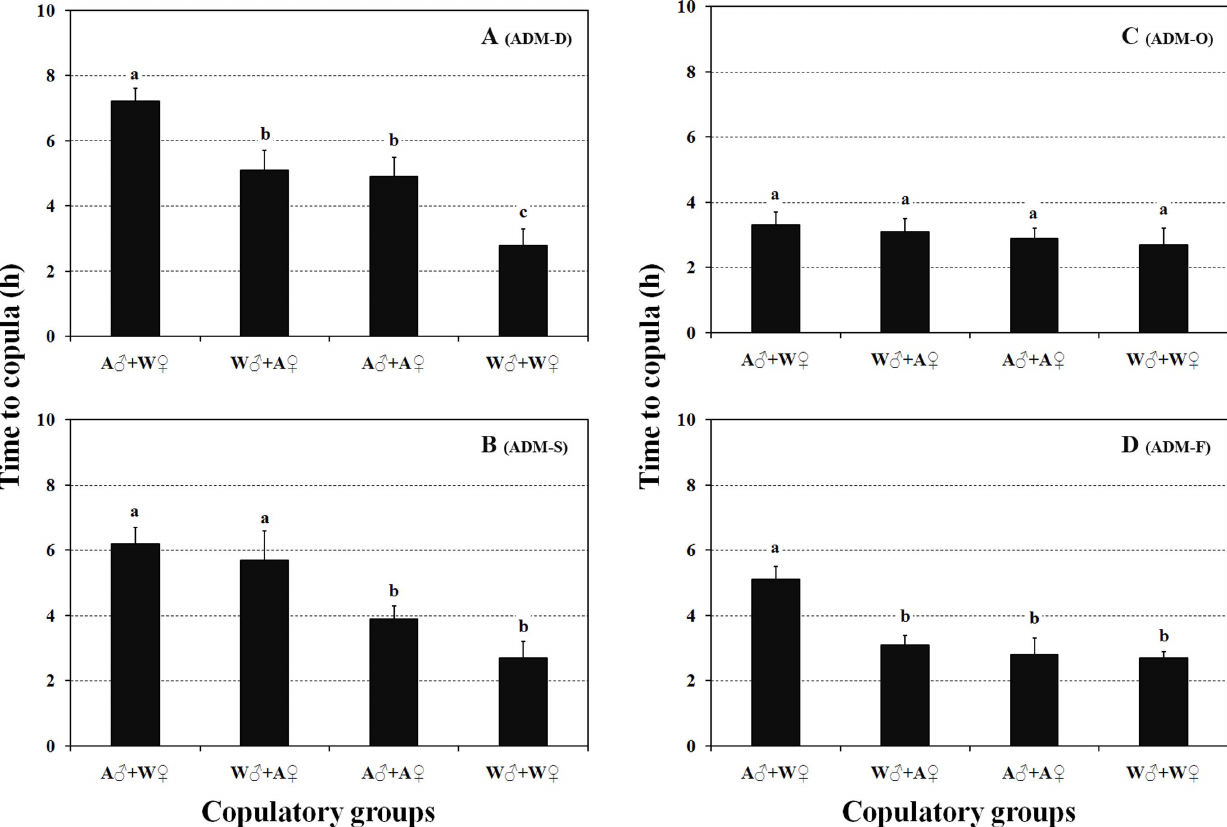
Figure 5. Mating preference (time to copula) of different copulatory groups comprising optimal ADM-reared and wild-collected O. sauteri adults (A: artificial reared; W: wild collected). The columns and bars represent mean + SE. The different letters at the top of the columns indicate significant differences based on the LSD test (P , 0.05).